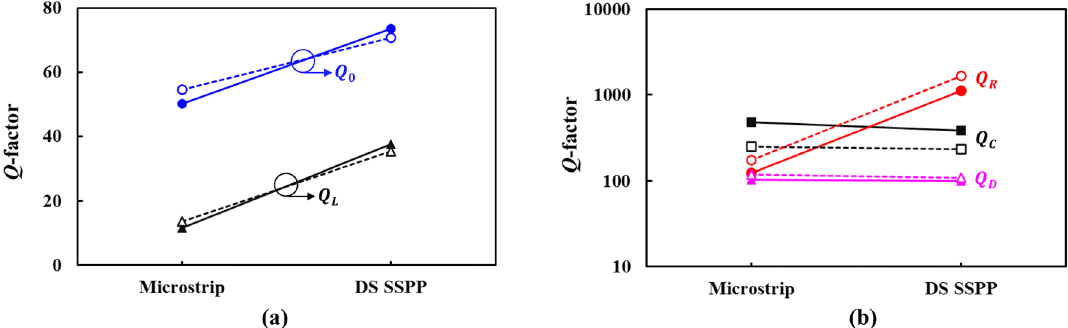
Figure 12. Calculated Q -factors of ring resonators at fundamental (slotted) and second harmonic (solid) resonant frequencies. ( a ) Q L and Q 0 . ( b ) Q C , Q D , and Q R .